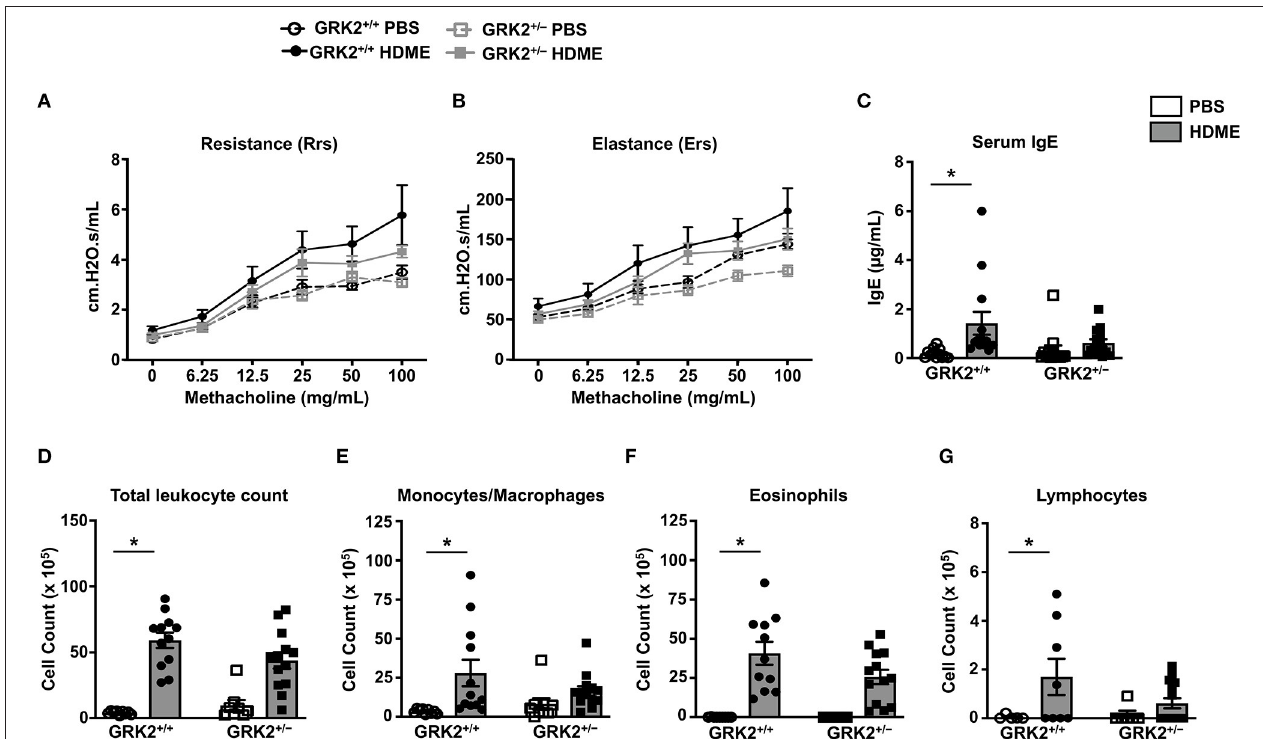
FIGURE 2 | AHR, serum IgE and immune cell counts in the BALF are not altered in GRK2 + / − mice challenged with HDME. (A,B) PBS control or HDME-exposed GRK2 + / + and GRK2 + / − mice were anesthetized 24h after the last HDME challenge and analyzed for AHR. (A) Lung constriction [Resistance [Rrs]] and (B) elastic stiffness of lungs, chest walls, and airways [Elastance [Ers]] after challenge with increasing doses of methacholine is shown. (C) Levels of serum IgE in GRK2 + / + and GRK2 + / − mice treated with PBS or challenged with HMDE. (D) Total leukocyte counts and differential cell counts of (E) monocytes/macrophages, (F) eosinophils, and (G) lymphocytes are shown. Data are presented as mean ± SEM and are pooled from 2 to 3 independent experiments with a total of 5–14 mice per cohort. Both male and female mice were used for these experiments. * p <